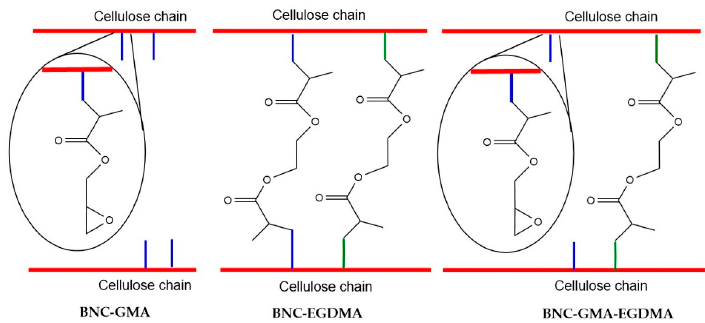
Figure 1. BNC-GMA (left); BNC-EGDMA (centre); BNC-GMA-EGDMA (right).